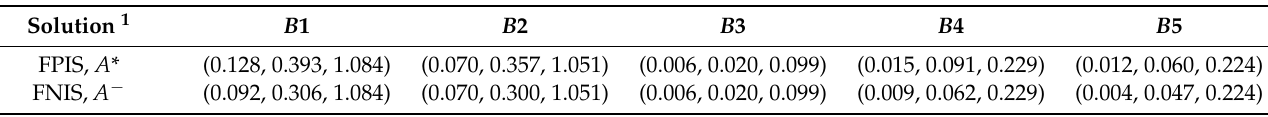
Table 11. Fuzzy Positive Ideal Solution (FPIS) and Fuzzy Negative Ideal Solution (FNIS) for information tools usage assessment by five criteria.